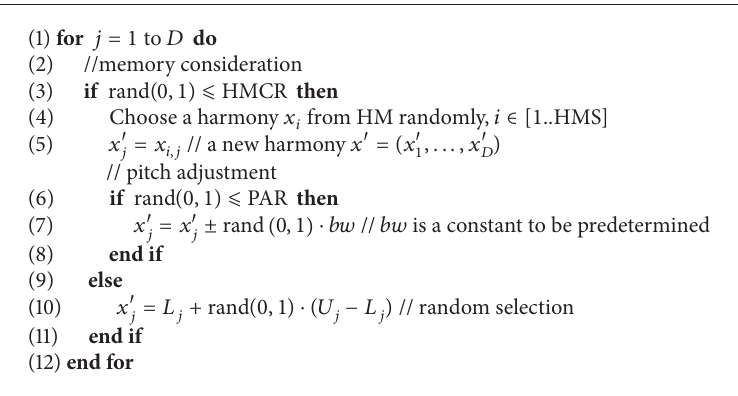
algorithm (GGA) for 0-1 knapsack problems. In GGA, a